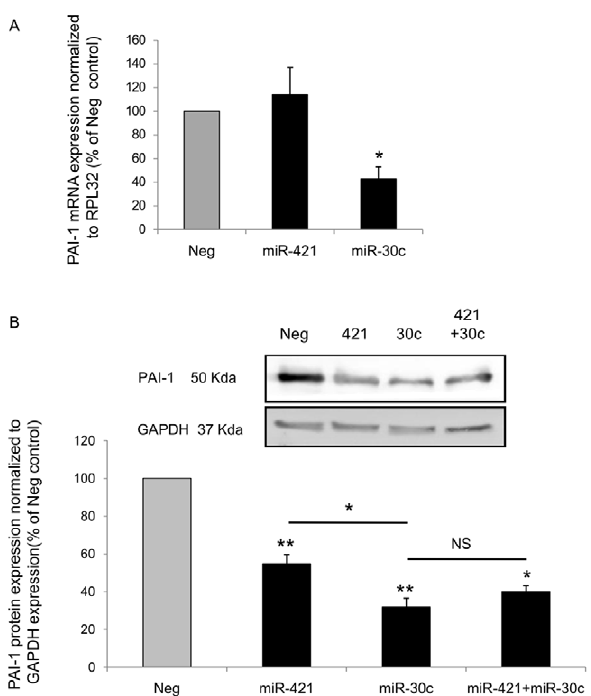
Figure 2. MiR-421 and miR-30c inhibit SERPINE1 expression in HUVEC. A. Quantification by qRT-PCR of PAI-1 mRNA level after over- expression of either Pre-miR-421, Pre-miR-30c or a Pre-miR Negative control (Pre-Neg) in HUVEC cells. RPL32 mRNA level was used for normalization and data shown were expressed as percentage compared to Negative control (*, p , 0.05 n=4). B. Western-Blot and quantification of PAI-1 and GAPDH protein level after over-expression of either Pre- miR-421, Pre-miR-30c or both compared to Pre- Neg transfected cells. Data shown were normalized to GAPDH protein level and expressed as percentage compared to Negative control (n=5 for miR-421 and miR- 30c, n=3 for miR-421 + 30c; *, p , 0.05; **, p , 0.01). doi:10.1371/journal.pone.0044532.g002 PLOS ONE |